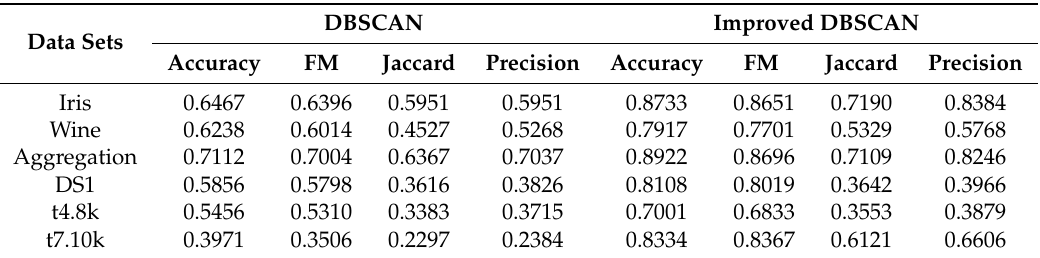
Table 3. Comparisons of clustering results in data sets.